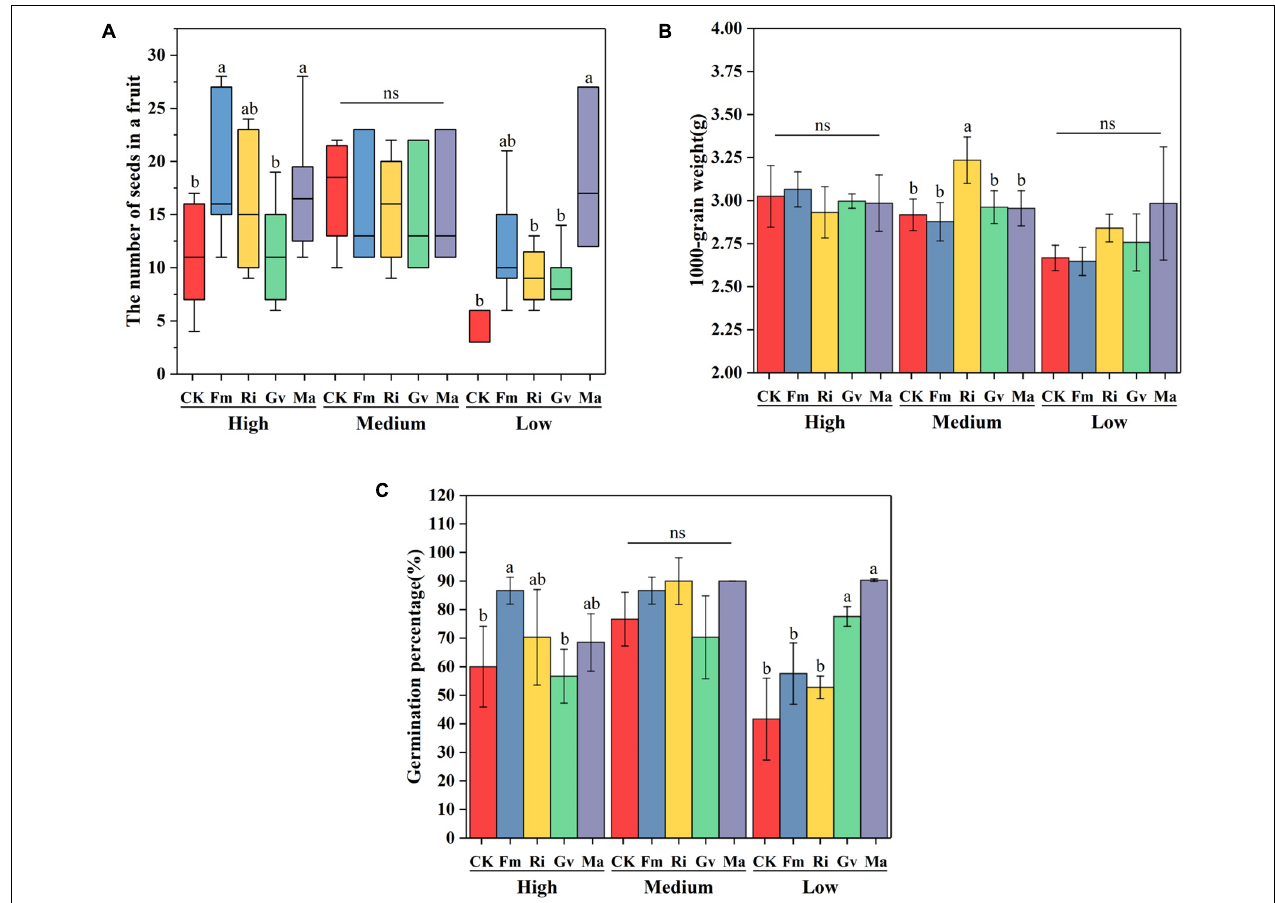
FIGURE 5 | Effects of AMF inoculation on seed number in a fruit (A) , seed 1,000-grain weight (B) , and seed germination percentage (C) of cherry tomato under different nutrient